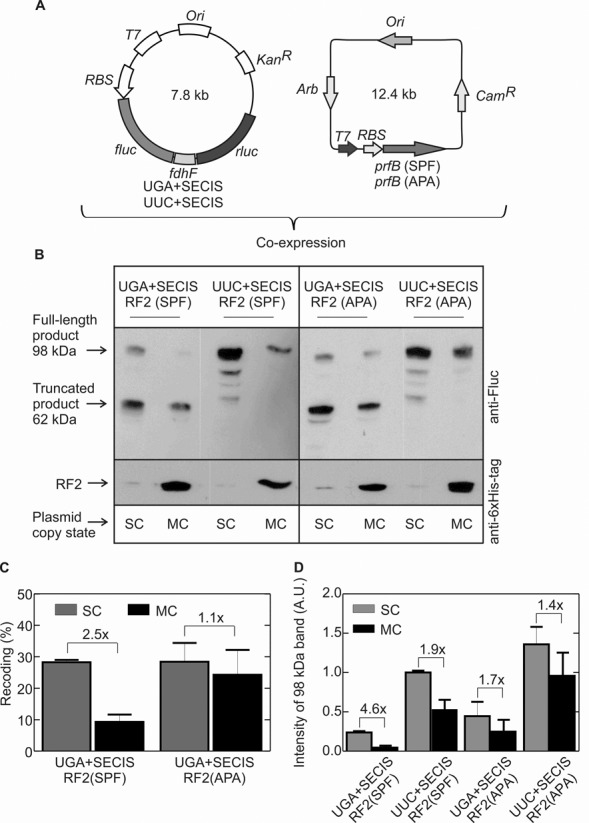
Effect of RF2 on Sec insertion in vivo. (A) Co-expression of Fluc–FdhF–Rluc and RF2 constructs. prf(SPF) is a construct for 0-frame expression of RF2 with the native stop-codon recognition motif (SPF). In the prf(APA) construct, the SPF motif is mutated to APA to produce RF2 that is inactive in translation termination. (B) Example of a sodium dodecyl sulphate-polyacrylamide gel electrophoresis separation of the Fluc–FdhF–Rluc expression products in the presence of RF2 (SPF or APA) obtained from a single-copy (SC) or multi-copy (MC) plasmids. Fluc-FdhF and Fluc–FdhF–Rluc products were visualized by western blot analysis using an anti-Fluc antibody. The identity of the smaller peptides observed with the UUC+SECIS construct is not known. The amounts of RF2 in the same samples were detected using an antibody against the His-tag of RF2 (see also Supplementary Figure S1). (C) UGA recoding analysis from the western blot band intensity. Recoding was calculated as the ratio of the read-through band over the sum of the read-through and truncated bands. Error bars represent SEM from two experiments. The extent of read-through obtained with the UUC+SECIS construct defines 100% read-through efficiency. (D) Direct comparison of the read-through band intensities for all constructs. The band intensity for the product of UUC+SECIS translation at the SC RF2 conditions was taken as 1. Error bars represent SEM from two independent experiments.